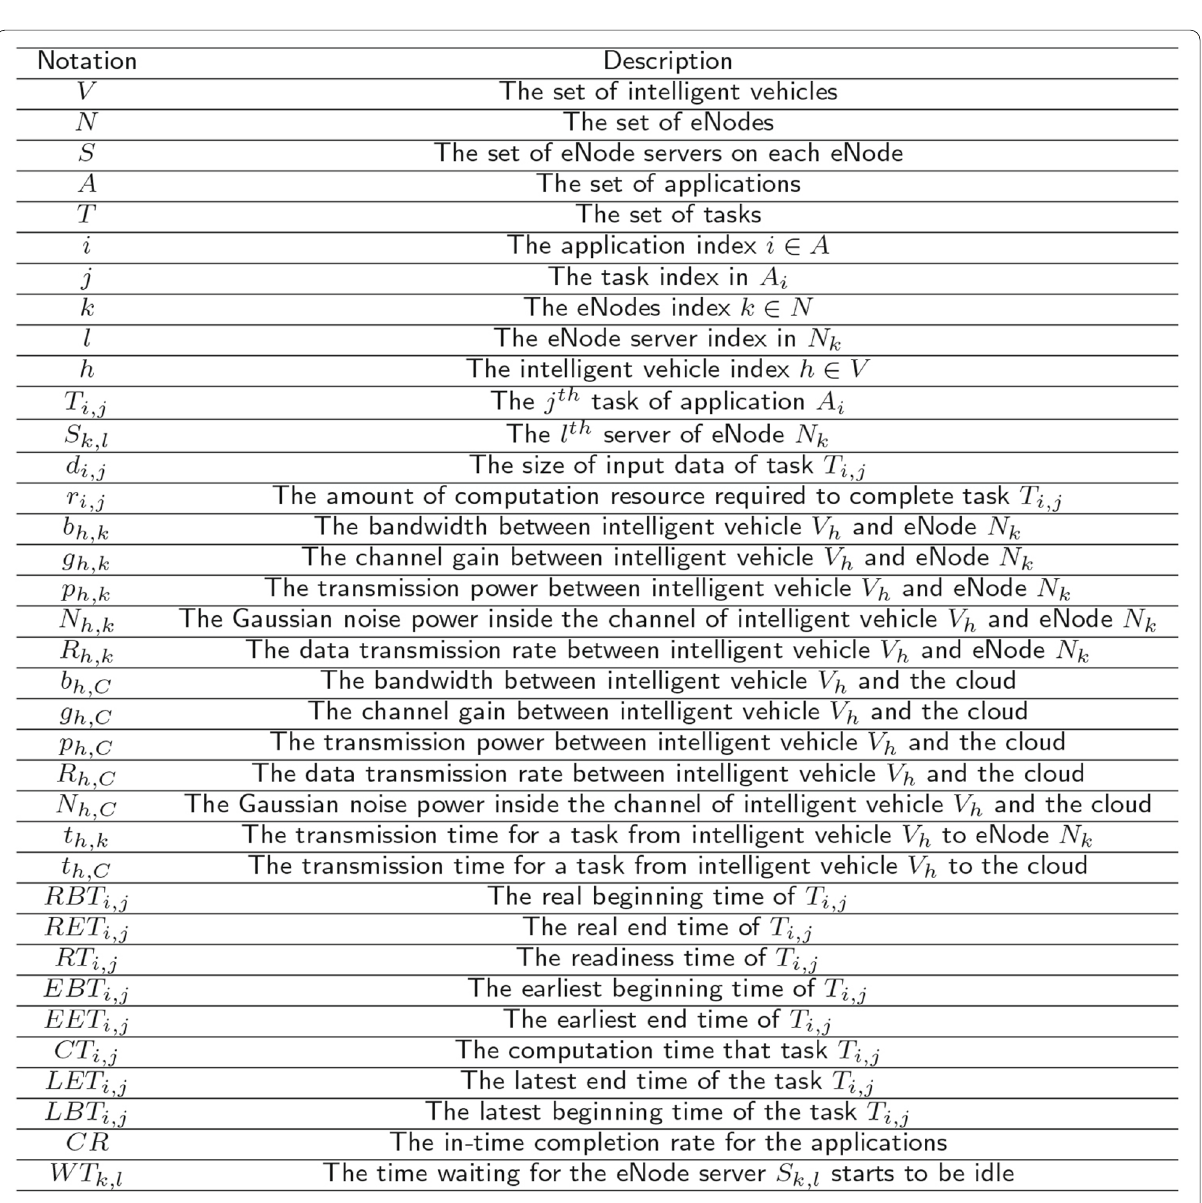
Fig. 2 Summary of Key